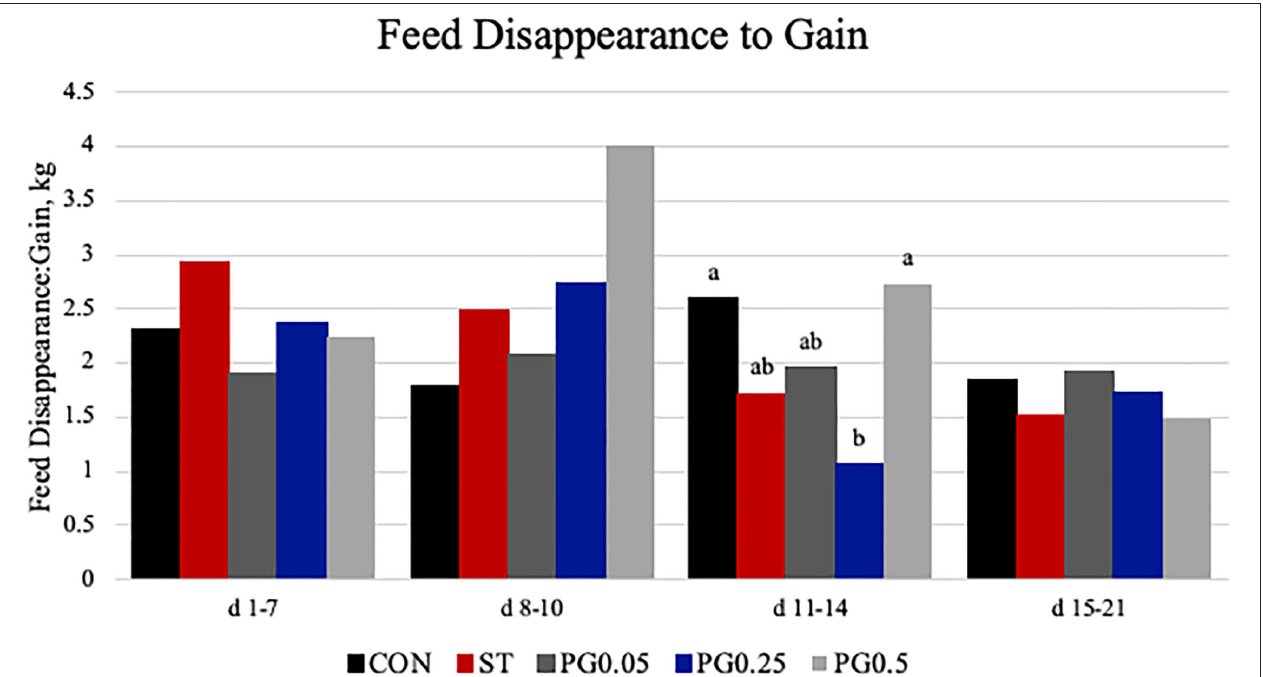
FIGURE 4 | Feed disappearance to gain was calculated from the feed disappearance and change in weight gain from days 1 to 7, 8 to 10, 11 to 14, and 15 to 21. There was a tendency for a treatment × time interaction ( P = 0.0593). On days 11–14, there was a tendency for treatment difference ( P = 0.0528), where treatment PG0.25 had decreased FD:G when compared to both PG0.5 and CON treatments ( P ≤ 0.0123). Largest SEM per time point is reported in kg and include 0.8118, 0.9323, 0.6647, 0.3707 for days 1–7, 8–10, 11–14, and 15–21, respectively. Bars with different superscripts are statistically different ( P < 0.05).